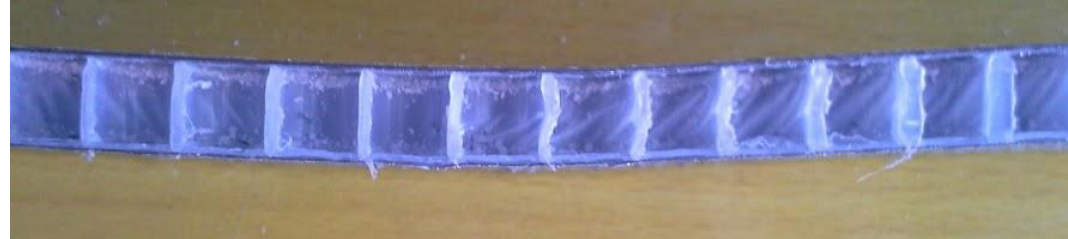
Figure 12. Sample after tested on the opposite skin. No visual damage was observed.